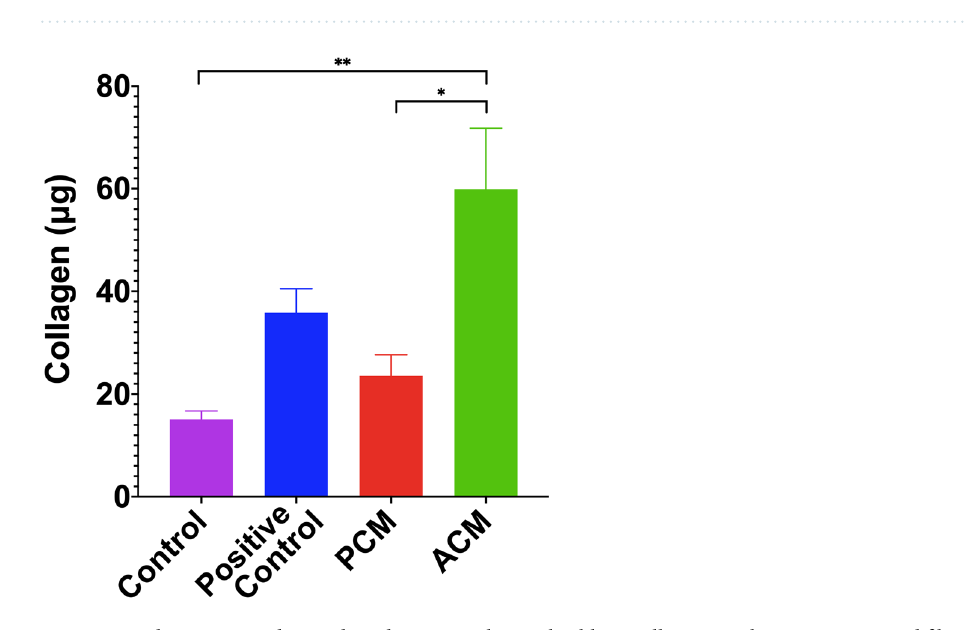
Figure 4. Adipocyte Conditioned Medium Stimulates Fibroblast Collagen Synthesis. ACM treated fibroblasts produced more than three times as much total collagen as controls and 1.5 times as much collagen as positive controls treated with TGF- β 1 and ascorbic acid. A one-way ANOVA with Tukey post hoc tests indicates significant differences ( * p < 0.05, ** p < 0.01). Data is presented as mean ± SEM (n = 3 independent experiments with three replicates for each